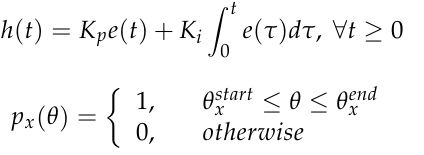
Figure 8. The control strategy implemented for FES cycling cadence